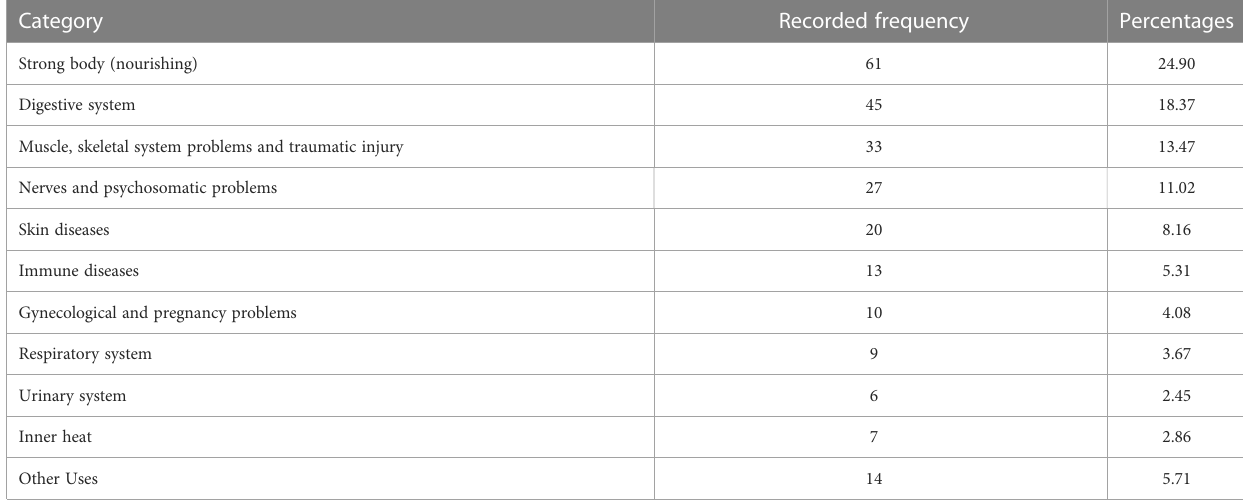
TABLE 1 Categories of diseases in the study